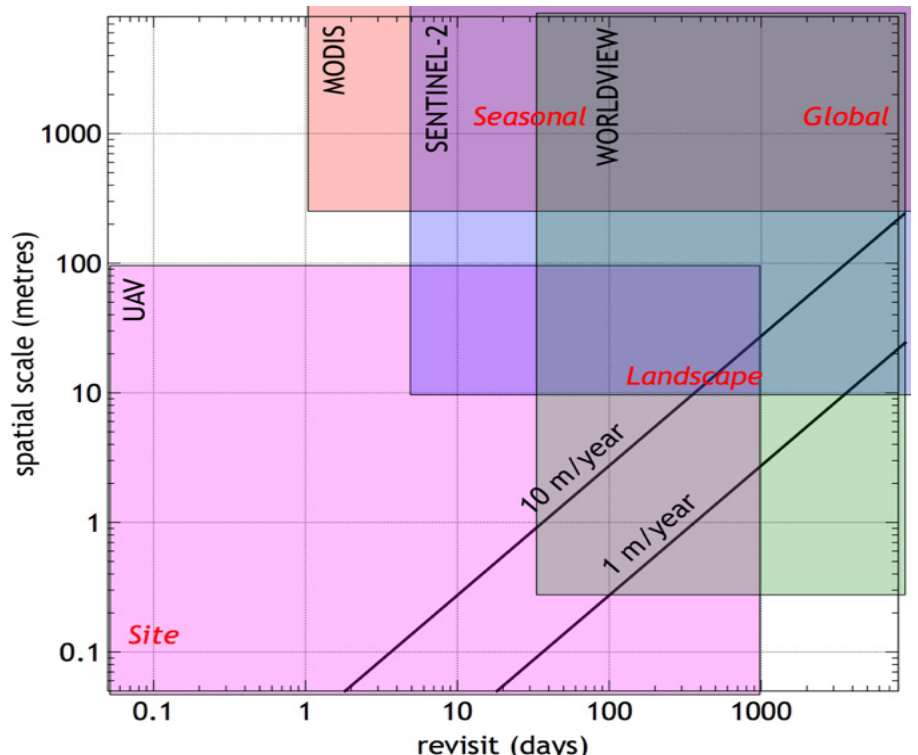
Figure 2. Schematic illustration of the useful ranges of spatial and temporal coverage of various representative remote sensing systems: UAV (Uninhabited Autonomous Vehicle), MODIS (Moderate-Resolution Imaging Spectroradiometer), Sentinel-2 and WorldView. The oblique lines show the combination of spatial and temporal resolution needed to capture a spatial process, such as coastal erosion or vegetation advance at a particular rate, as discussed in the text. The phenomena labelled in red represent different observation objectives, also discussed in the text.